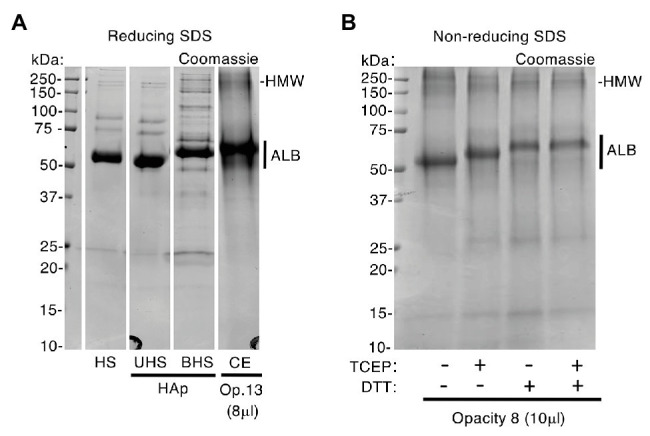
Enamel albumin differs from fresh serum albumin. An excess of human serum (HS) was exposed to hydroxyapatite (HAp) yielding unbound and bound fractions (UHS, BHS) as described under Methods. Samples of serum, chalky enamel (CE), and fresh serum albumin were then subjected to SDS-PAGE under reducing (100 mM DTT and/or 4 mM TCEP in SDS loading buffer) and non-reducing conditions (no DTT or TCEP), followed by Coomassie Blue staining as indicated. (A) After being bound to hydroxyapatite, albumin from human serum (BHS) exhibited reduced mobility, matching that of enamel albumin (CE; opacity 13). In contrast, the unbound albumin showed unchanged mobility when compared with starting serum (UHS and HS, respectively) and fresh albumin standard (not shown). (B) In absence of DTT and/or TCEP (leftmost lane), enamel albumin from opacity 8 migrated faster (compare with A), matching the fresh albumin standard (not shown). Reduction with TCEP induced an intermediate mobility state when compared with DTT. The high molecular weight albumin bands (HMW; see also Figure 3) were enhanced in the absence of reducers, consistent with disulfide-based aggregation. Sample loads were 8 and 10 μl (i.e., 0.8 and 1 μl enamel-powder equivalents) for opacity 13 and 8, respectively. This figure was composited from a (A) a single Coomassie-stained gel, and (B) a second Coomassie-stained gel.